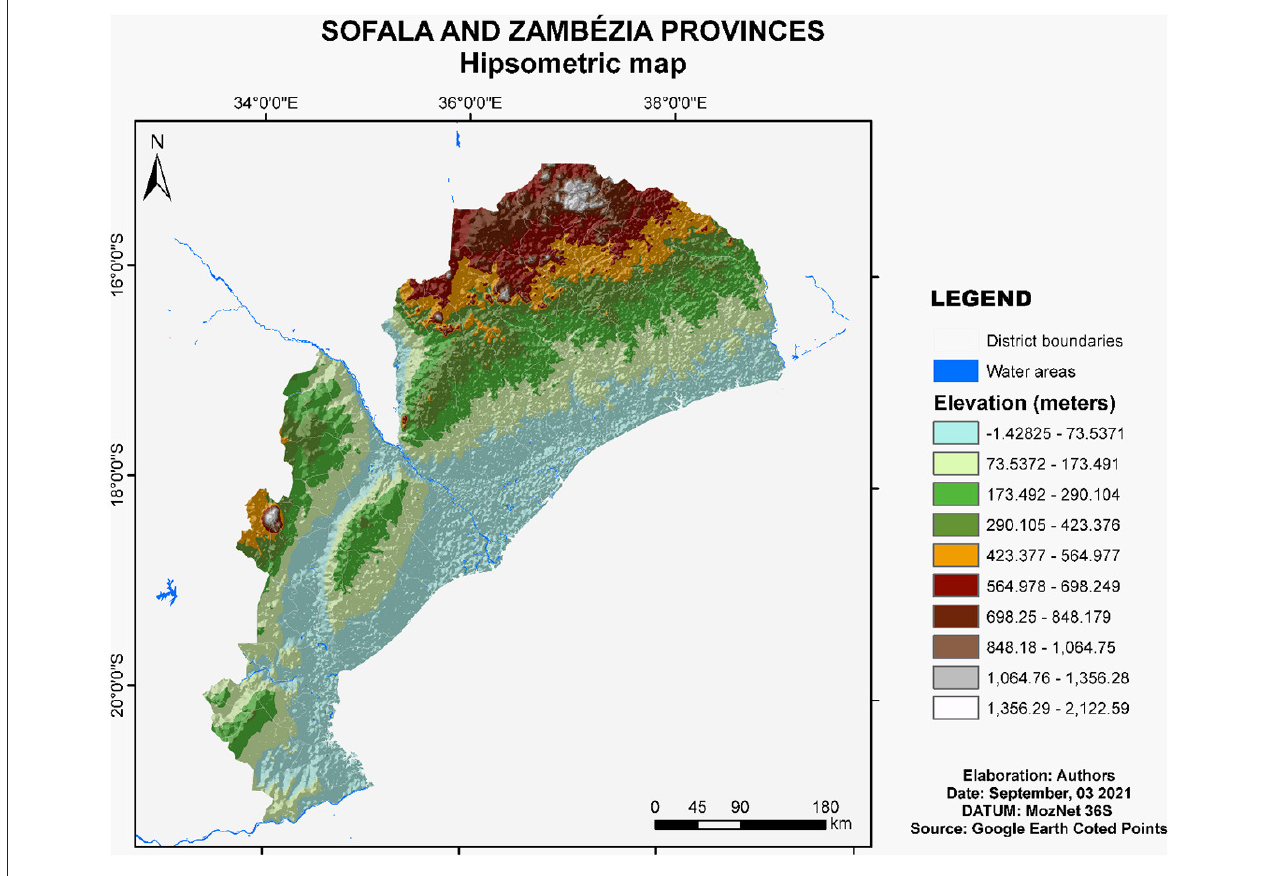
FIGURE 2 | Hypsometric map. Source: